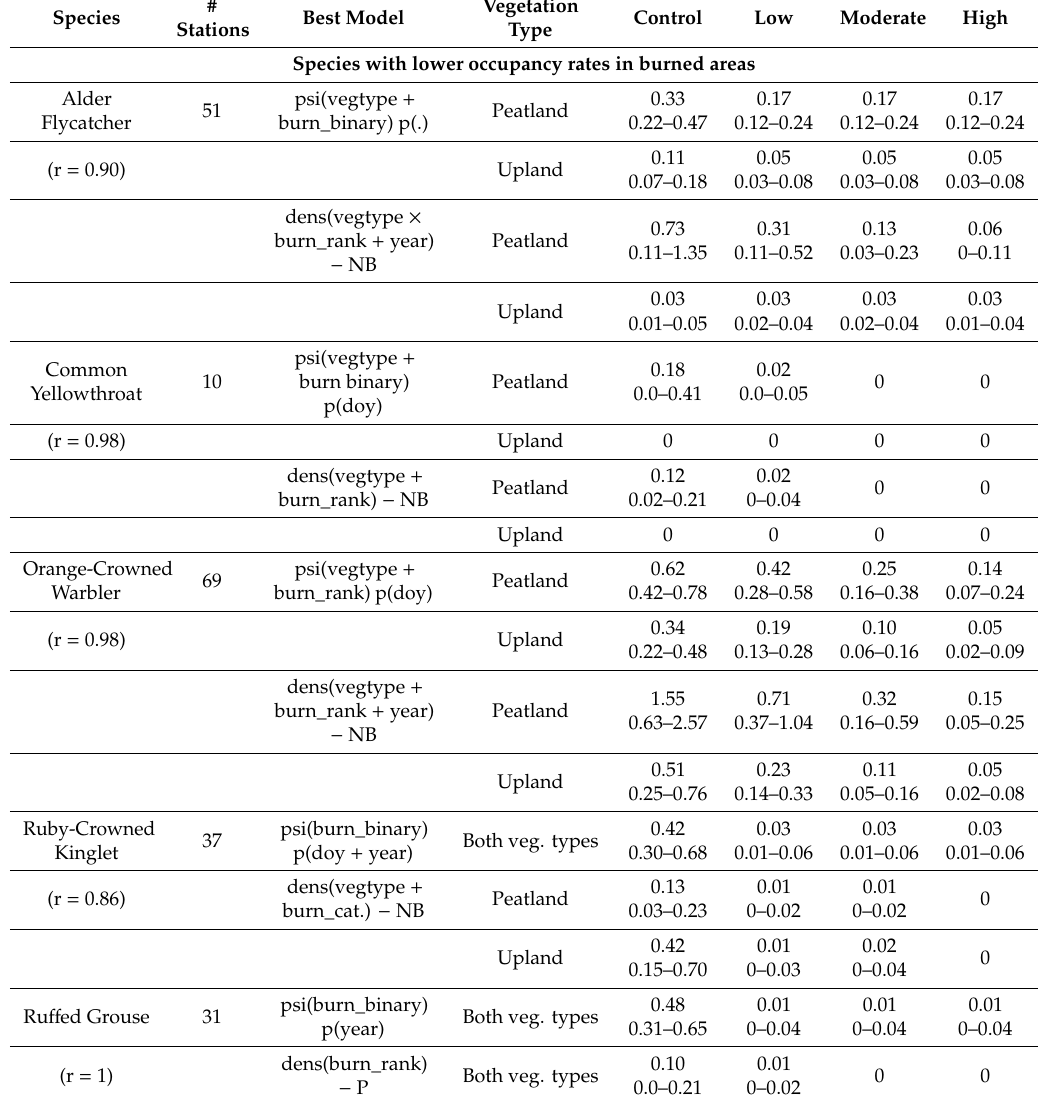
Table 1. Mean ( ± 95% C.I.) occupancy probability (psi) and density (dens; males per hectare) estimates for 20 species in peatland and upland forest with di ff erent burn severities (Control, Low, Moderate, and High). Results are derived from the best fitting model, i.e., lowest Akaike’s information criteria (AIC). Additionally, presented here are the: (1) correlation (r) between occupancy and density across the 8 categories for each species and (2) number of stations where the species was detected at least once. Species are grouped based on their response to fire severity from the occupancy models. Species in bold italics show di ff erent qualitative patterns in their response to fire between occupancy and density. p is the detection terms in the occupancy model. P or NB indicates whether a Poisson or negative binomial model provided a better fit to generate density estimates. Veg. =